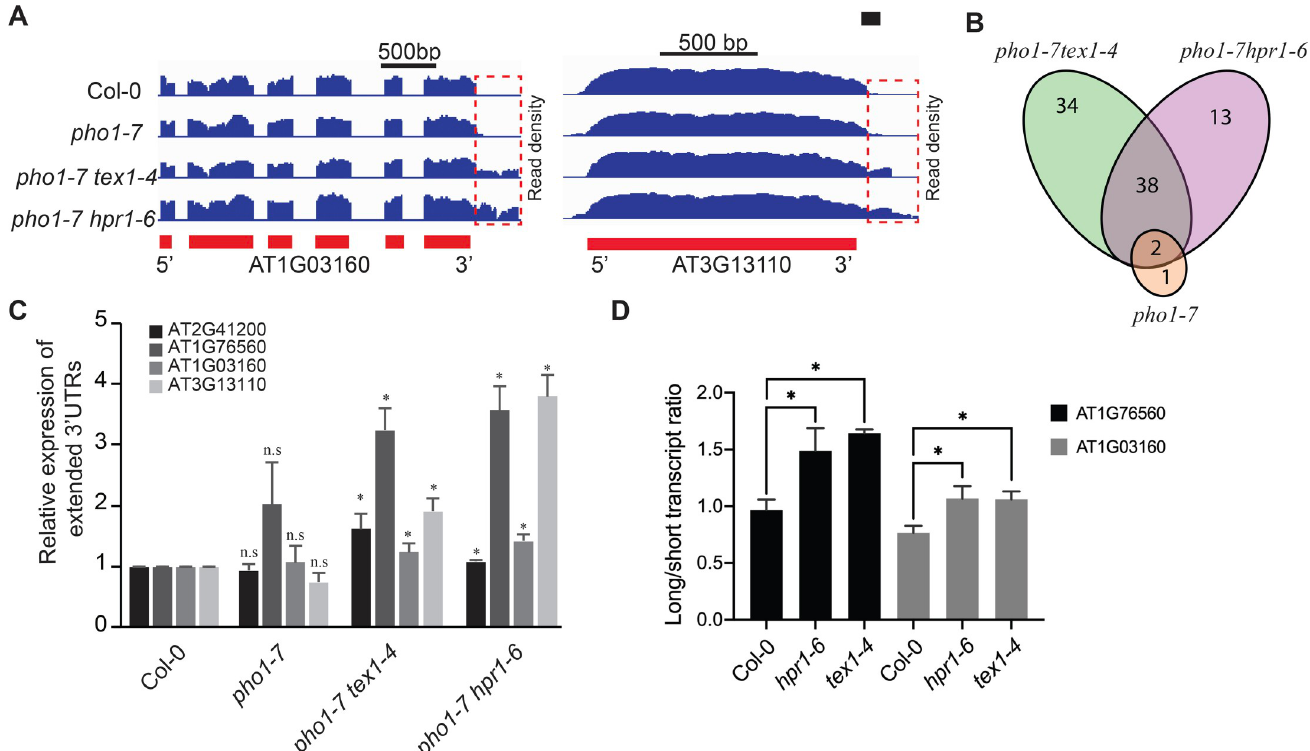
Fig 6. UTR extensions in endogenous genes of the pho1-7 tex1-4 and pho1-7 hpr1-6 mutants. 3 0 (A) Illumina RNAseq reads density maps (blue) showing examples of 3’ UTR extensions for genes AT1G03160 (left) and AT3G11310 (right) in the pho1-7 tex1-4 and pho1-7 hpr1-6 mutants. The 3 0 UTR extensions are depicted by a red rectangle. The exons of the genes are indicated as red boxes below. (B) Venn diagram showing the number and overlap in genes with 3’UTR extensions. (C) Validation of 3’ UTR extensions via qPCR. (D) Transient expression of Luciferase gene fused after the stop codon to the 3’end of genes AT1G76560 and AT1G03160. The constructs were expressed in Arabidopsis mesophyll protoplasts obtained from Col-0, hpr1-6 and tex1-4 . The bar chart shows the relative ratios of long-to-short transcripts in the various genotypes. For C, data are means of three samples with each sample being a pool of seven seedlings and three technical replicates for each sample. For D, data are means of four samples with each sample being an independent transfection of protoplasts. Error bars represent standard deviation. Asterisks denote statistical significance (P < 0.05) from the Col-0 control according to Student’s t test (n.s. = not statistically different).